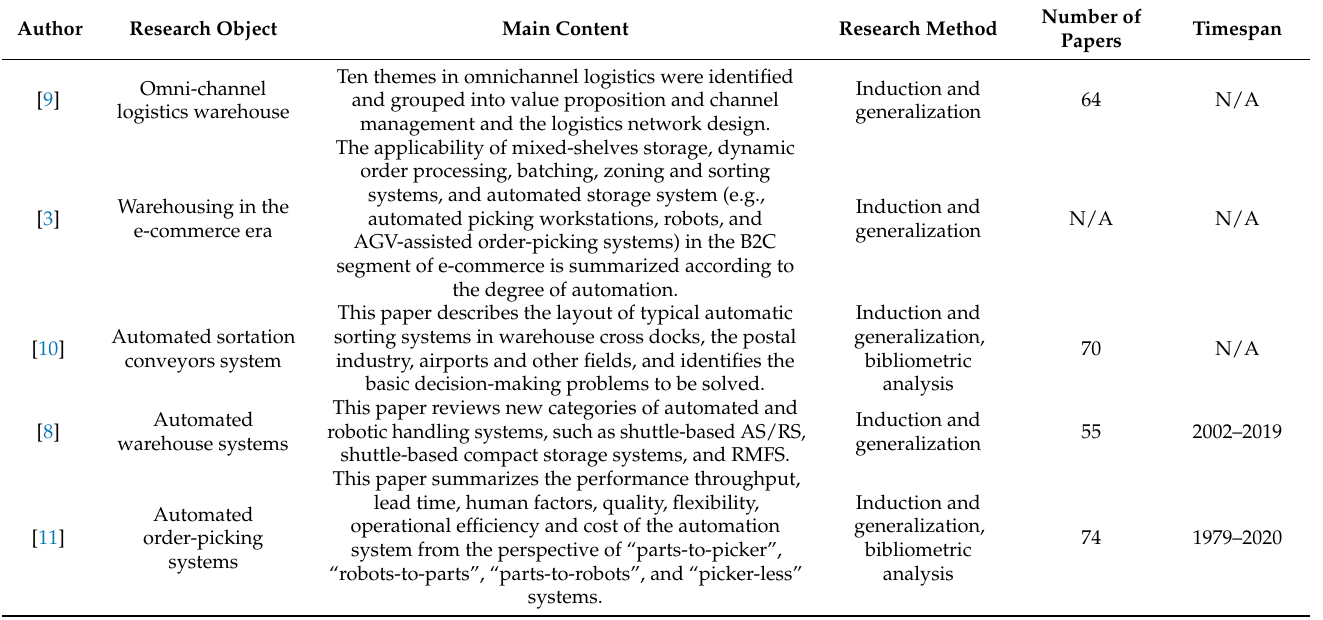
Table 3. Summary of literature reviews related to order picking in e-commerce warehouses.